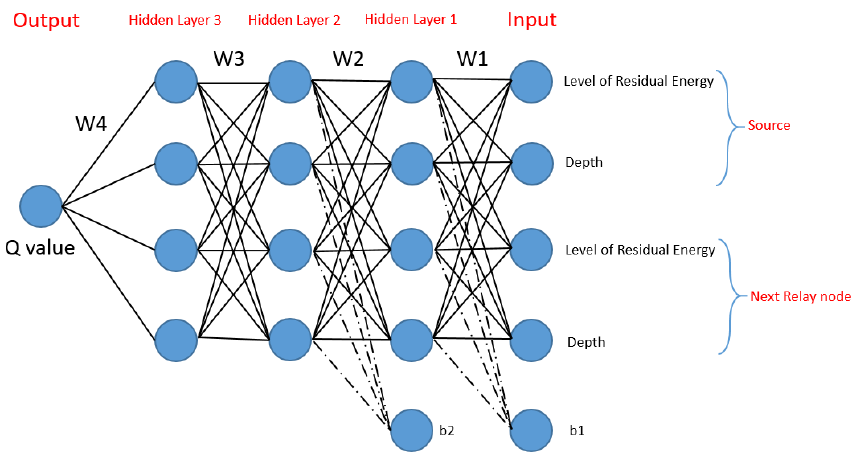
Figure 14. Multi-layer perception (MLP) neural network model.